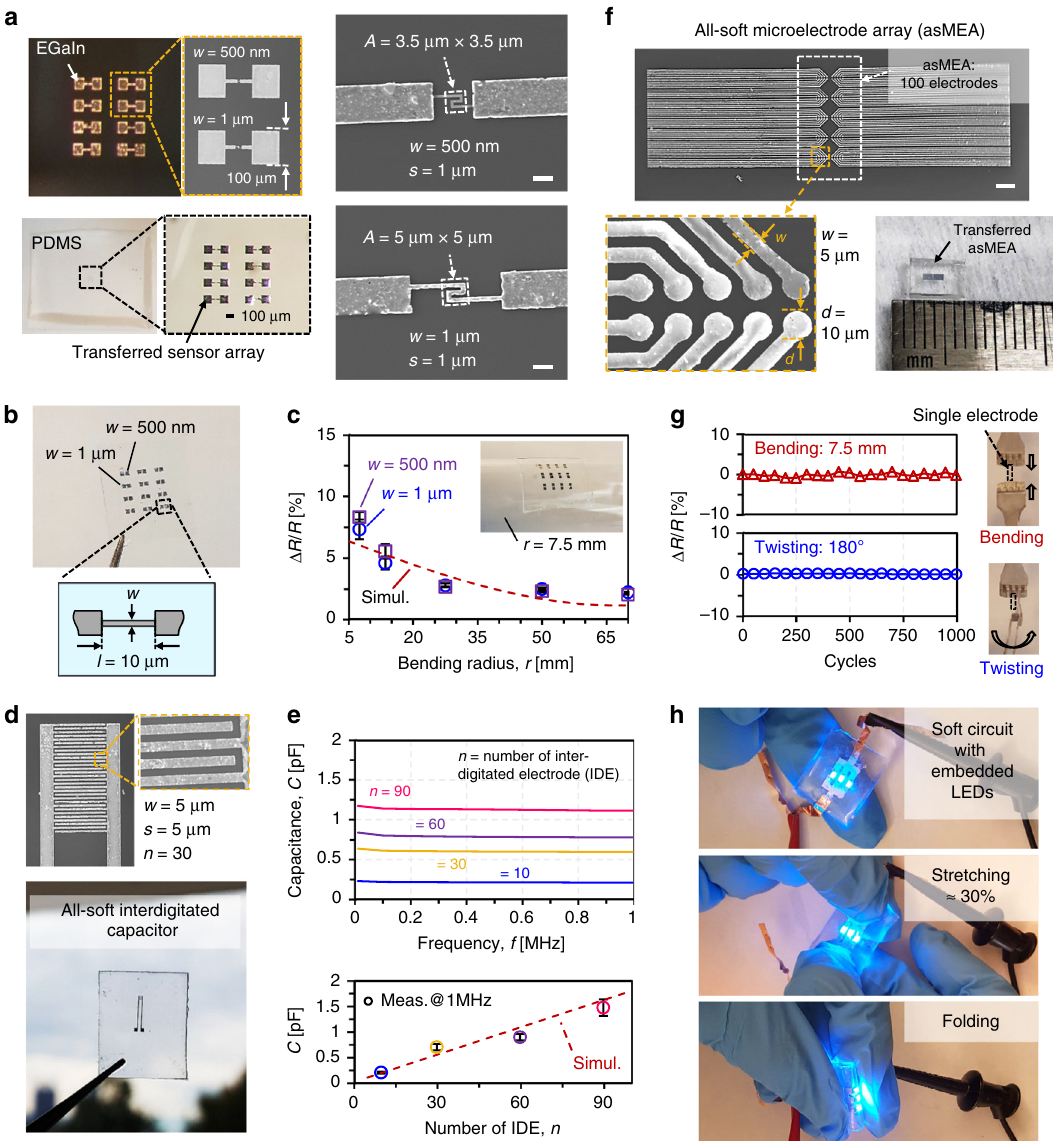
Fig. 5 Fabricated all-soft electronic devices. a Resistive sensor arrays fabricated on a Si wafer with 500 nm line width and 1 µ m spacing, and 1 µ m line width and 1 µ m spacing; Encapsulation with soft elastomeric material, such as PDMS, and release of soft resistive sensor array from the Si wafer. Scale bars indicate 5 μ m. b Strain sensor array with straight-line resistors having 500 nm and 1 µ m line widths and c measured and simulated relative resistance changes Δ R / R of the resistive strain sensors as a function of the bending radius. The y-error bars represent the standard deviation. d Interdigitated capacitors with 5 μ m line width and spacing and e measured capacitance as a function of frequency (top) for different numbers of interdigitated electrodes (IDE) as well as measured and simulated capacitance as a function of the number of IDE (bottom). The y-error bars represent the standard deviation. f Microelectrode array with 100 electrodes (scale bar, 100 μ m) and g measured relative resistance change as a function of the number of bending and twisting cycles (bending was performed around a cylinder with 7.5 mm radius, and twisting was performed to a 180 ˚ angle). h Fabricated soft circuit with three embedded LEDs under mechanical stretching and folding